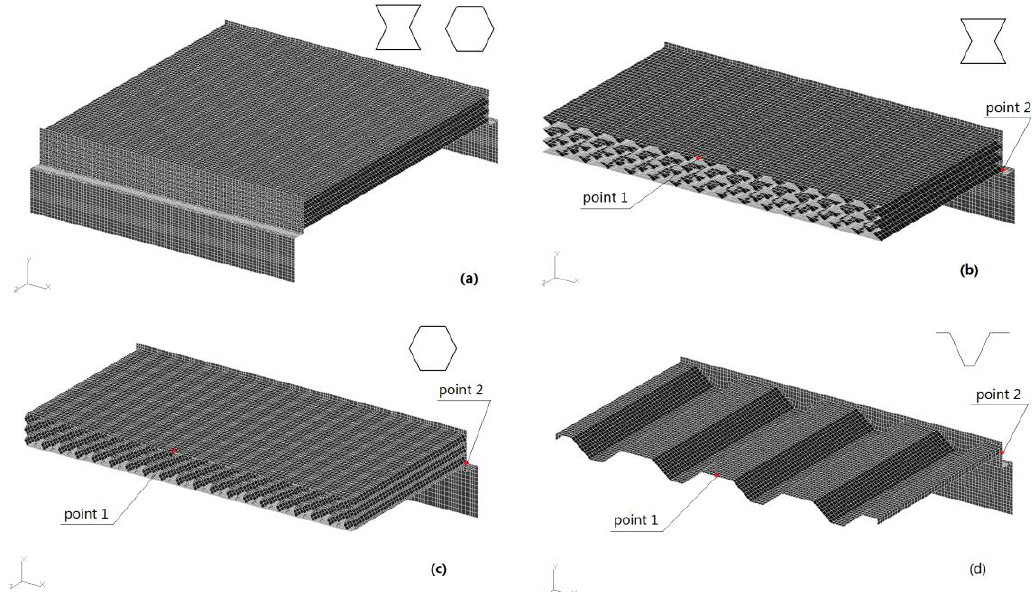
Figure 6. Finite element models: ( a ) the whole model, ( b ) 1 / 2 symmetry of the ARBW, ( c ) 1 / 2 symmetry of the CBW.